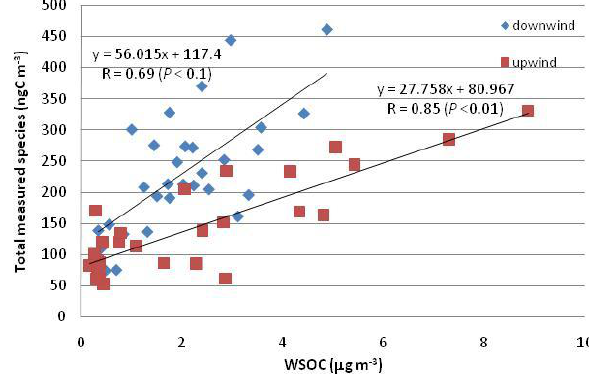
Fig. 4. Relationship between the concentrations of total quanti- fied water-soluble organic compounds (TQWOC) and total water- soluble organic carbon